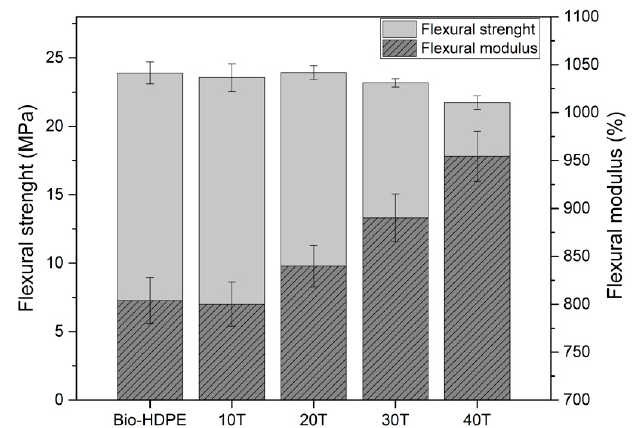
Figure 7. Effect of weight percentage of treated chia seed flour with APS on flexural properties in bio-based high-density polyethylene (Bio-HDPE).